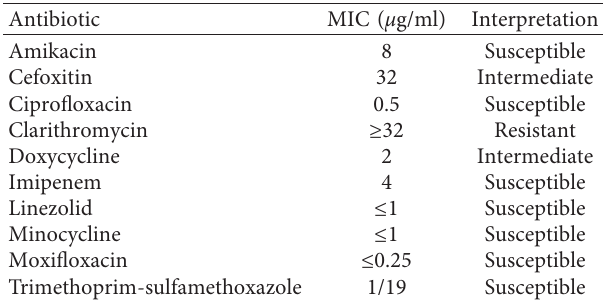
Table 1: The Mycobacterium mageritense isolate demonstrating susceptibility to several antimicrobial agents.